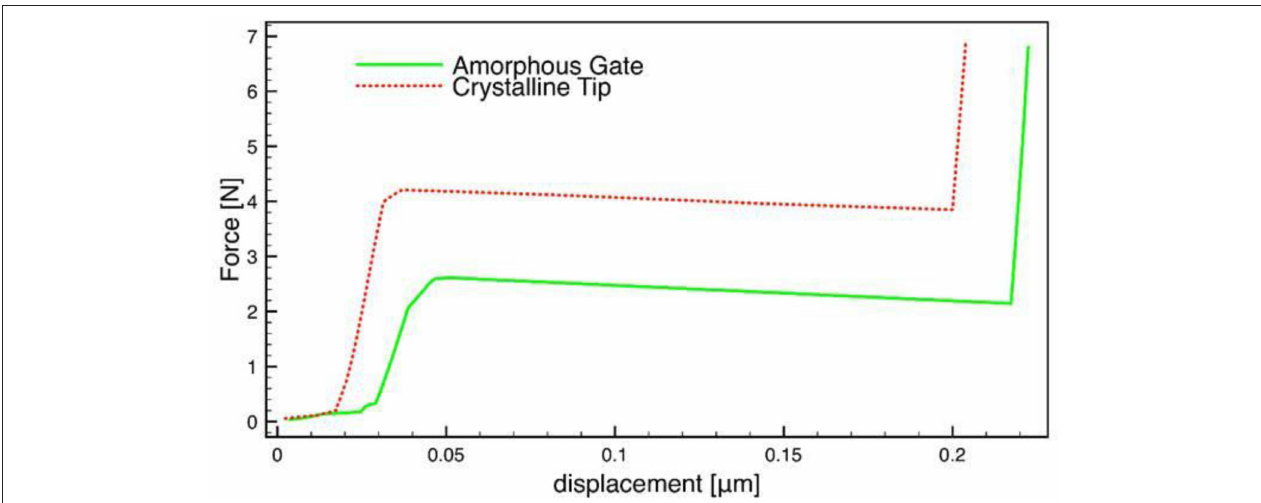
FIGURE 12 | Example of evolution of the force vs. displacement in the two zones (amorphous and crystalline) of the same hydrolyzed sample for which the break is observed.